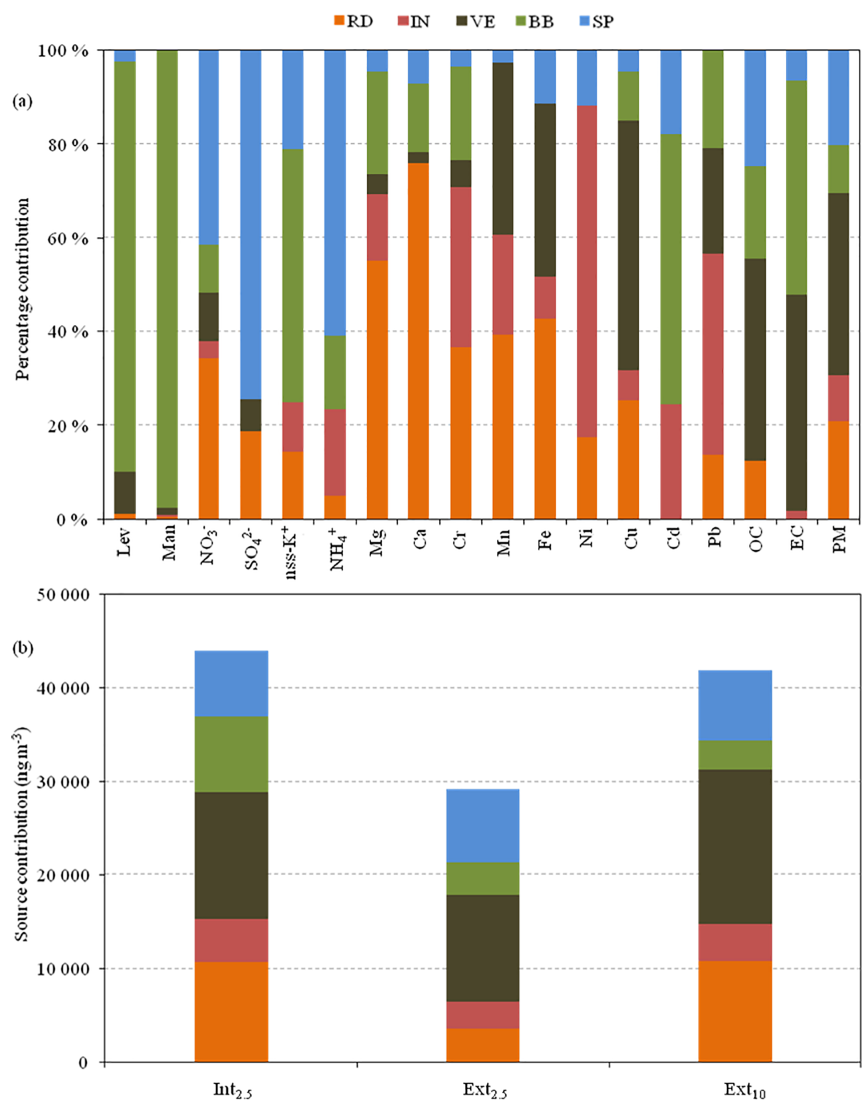
Figure 9. (a) Profile of species for each source (RD – road dust, IN – industrial, VE – vehicular, BB – biomass burning and SP – secondary processes). (b) Contribution of sources for each